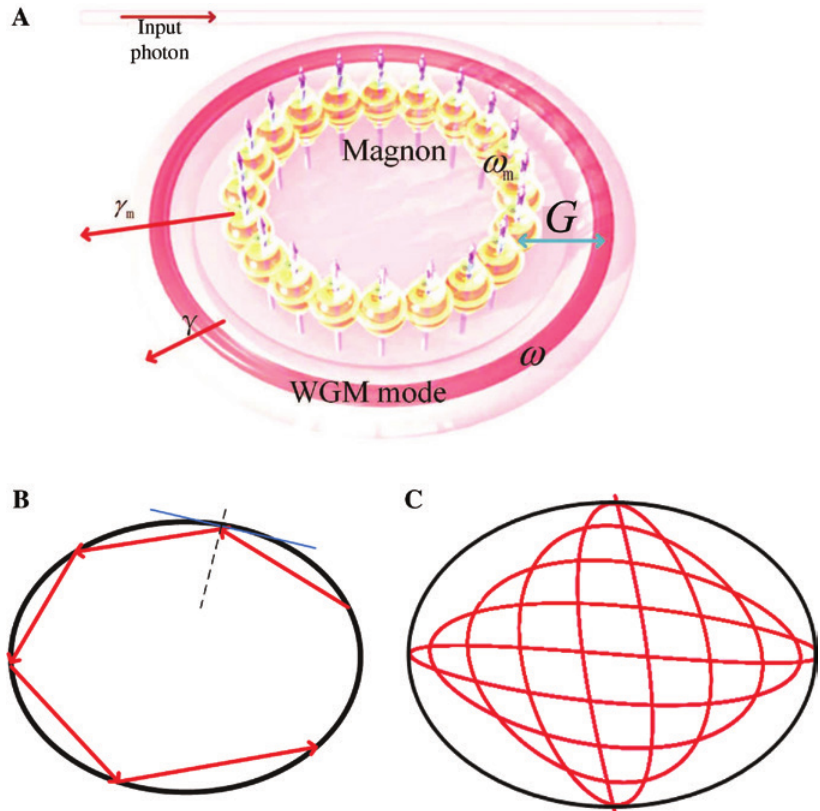
Figure 1: Schematic diagram of the model. (A) The cavity optomagnonic system. Here the frequency and dissipation of the optical whispering-gallery mode (WGM) are denoted as ω and γ , respectively. The frequency and dissipation of the magnons are denoted as ω the magnons and the optical WGM mode is G . (B) The trajectory of the light that is trapped in a deformed cavity. (C) The evolution of the states that is limited to a certain